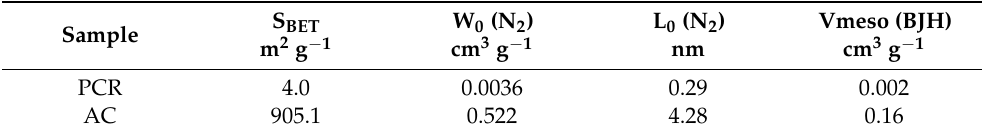
Table 1. Porous textural characteristics of the pyrolyzed coffee residue (PCR) and the synthesized activated carbon (AC).